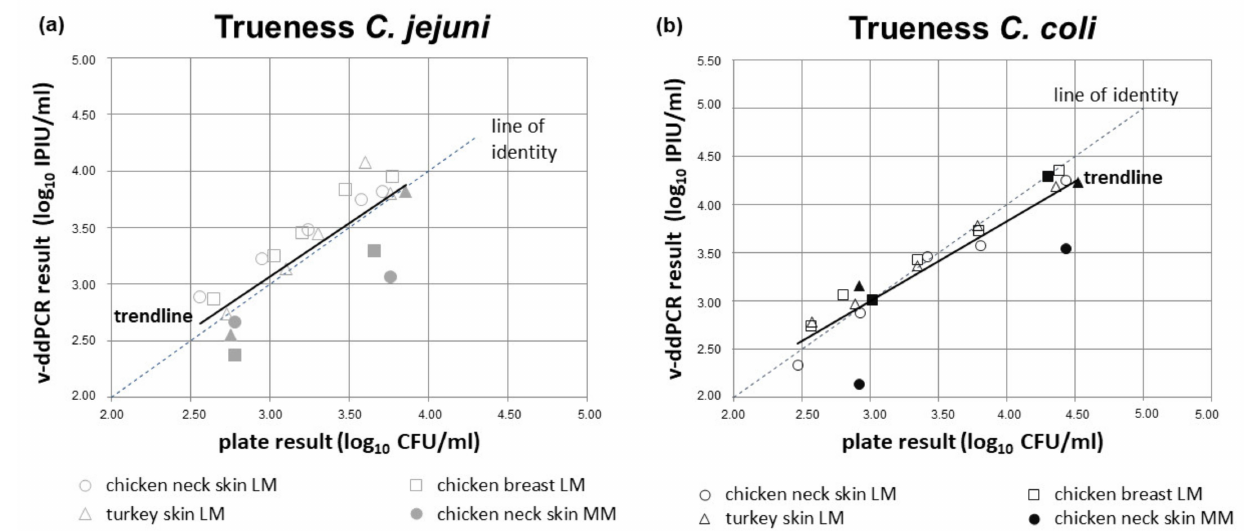
Figure 2. Scatter plot of alternative v-ddPCR method versus the microbiological reference method for determination of the relative trueness on three different types of raw meat matrices for ( a ) C. jejuni and ( b ) C. coli . LM: Low organic Matrix (represented by non-filled measurement points); MM: Medium organic Matrix (represented by solid-filled measurement points).